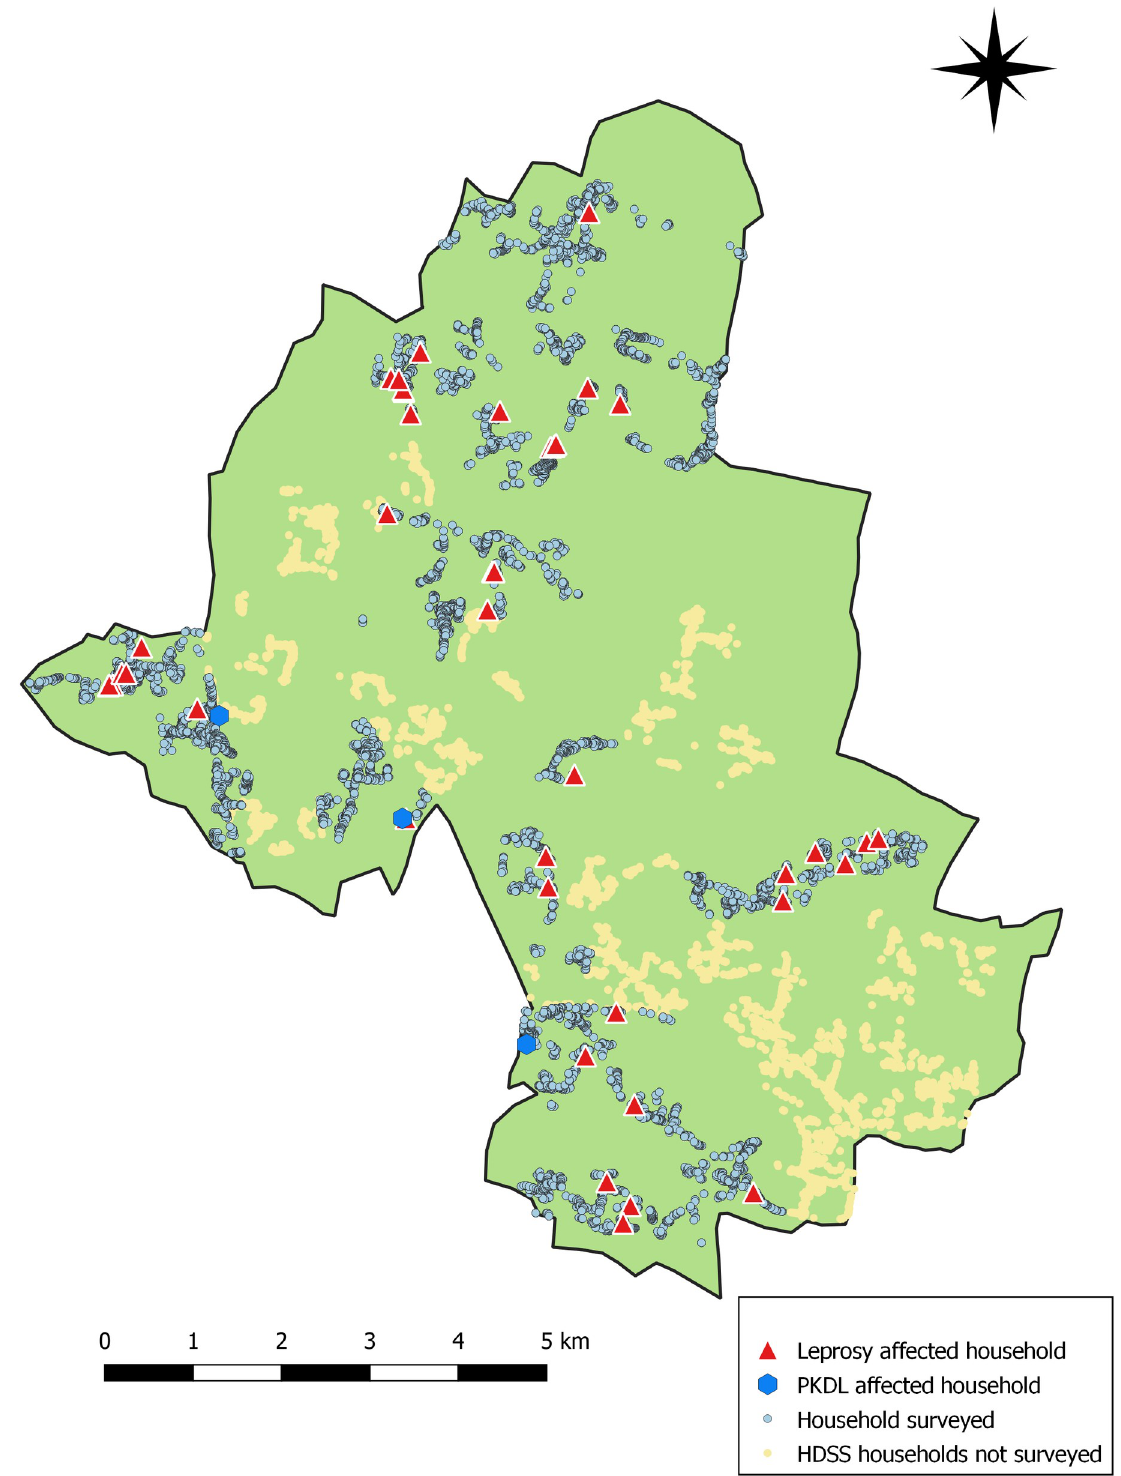
Fig 2. Muzaffarpur HDSS. Distribution of PKDL and leprosy in the area surveyed (map created in QGIS version 3.4.6-Madeira).